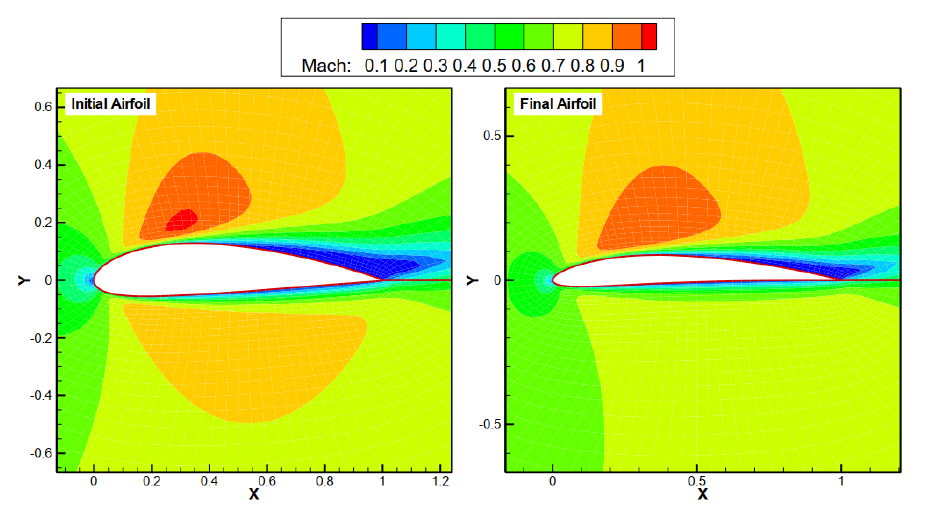
Figure 9. The Mach number contour around an airfoil was examined under the initial and final conditions of the proposed multipurpose optimization algorithm.